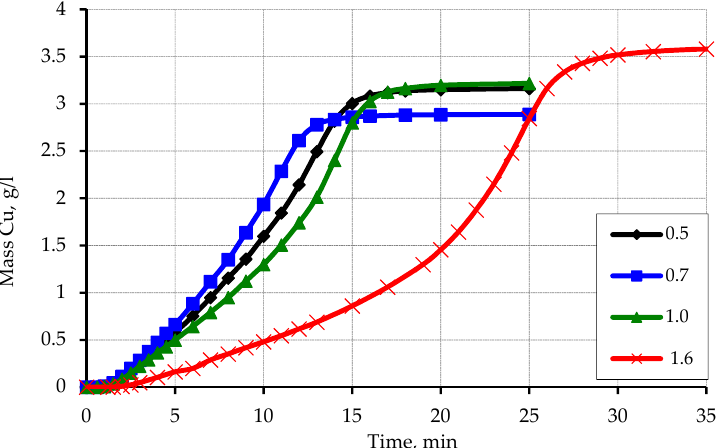
Figure 9. Kinetic curves of copper ion reduction on the activated surface of polypropylene depending on